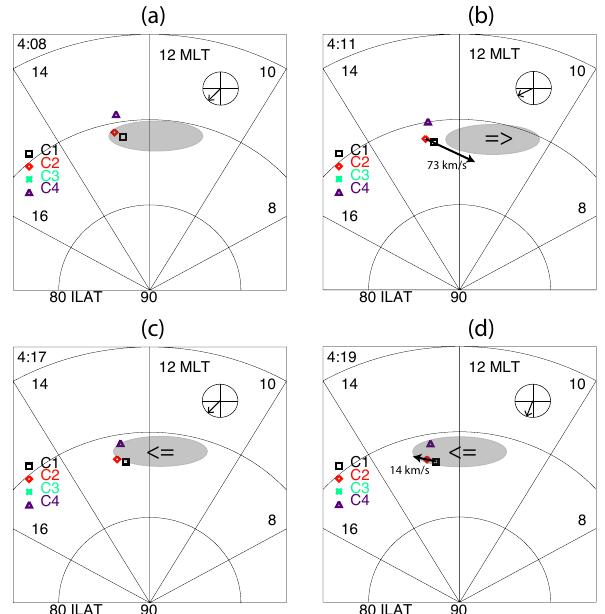
Fig. 6. Sketch of the position of the cusp with respect to C1, C2 and C4 in ILAT-MLT diagrams for four different times: 04:08UT, 04:11UT, 04:17UT and 04:19UT. These four times are marked on Fig. 5 for reference. The IMF clock angle is indicated in the upper right corner of each diagram. The motion of the boundary of the cusp measured between C1 and C2 is given by the thin black arrow. The direction of motion of the cusp is sketched by the wide arrow.